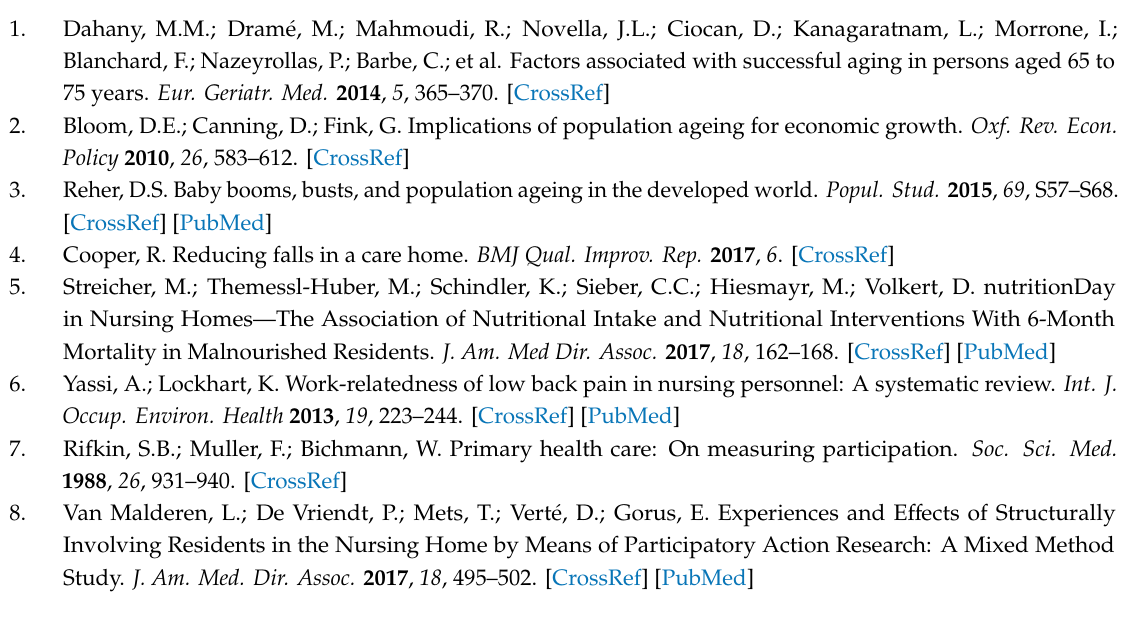
Table S1: Query combinations, Table S2: Critical appraisal: Available online: https: // drive.google.com / file / d / 1lYg9gcG0T6QjzHMuly7iFTAti6MYL49D /